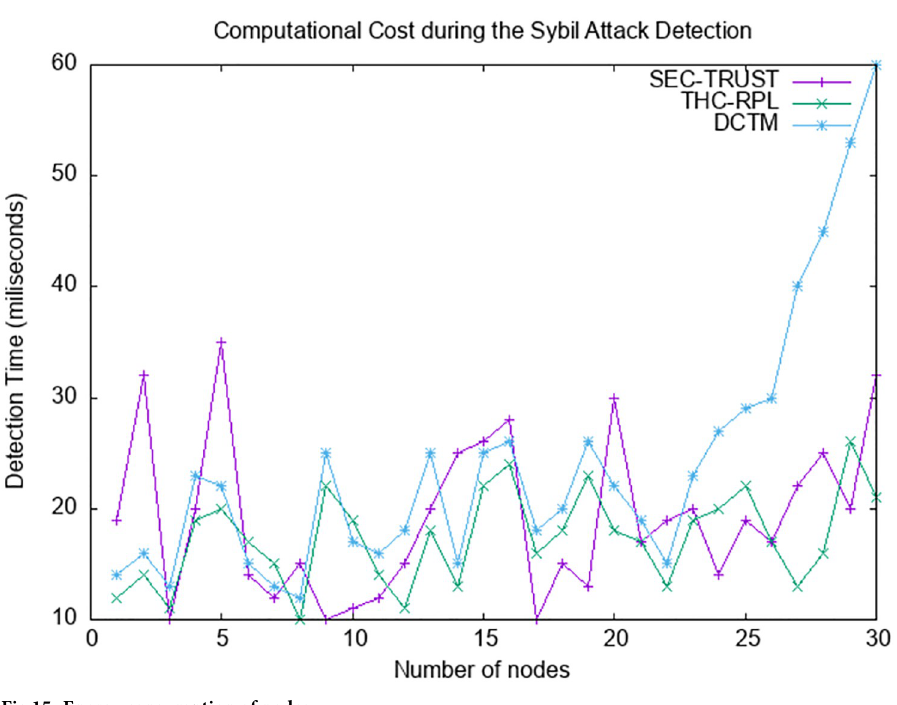
Fig 15. Energy consumption of nodes.